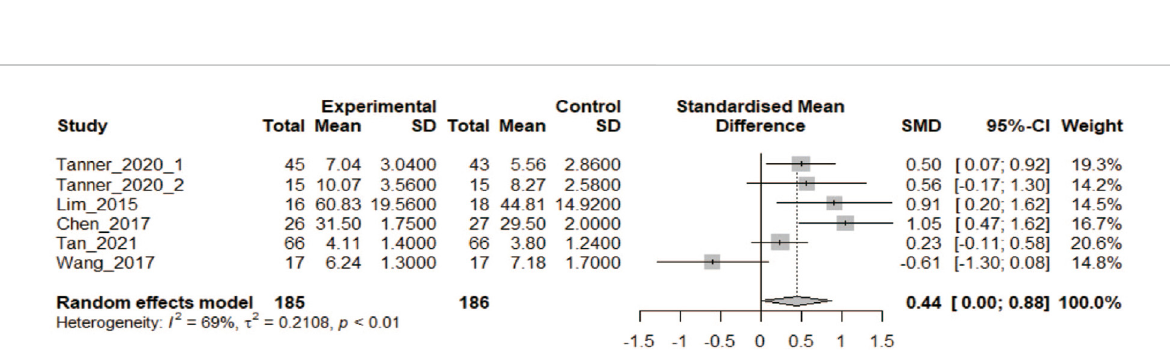
FIGURE 6 In the comparative study of 3DPs vs. Physical model, the combined data were used to compare the test scores of the two groups after training.